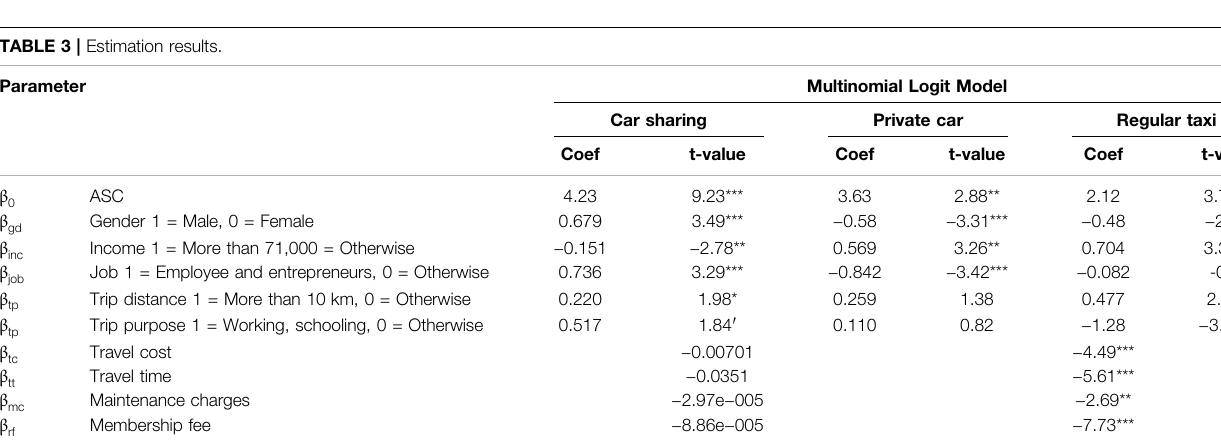
TABLE 3 | Estimation